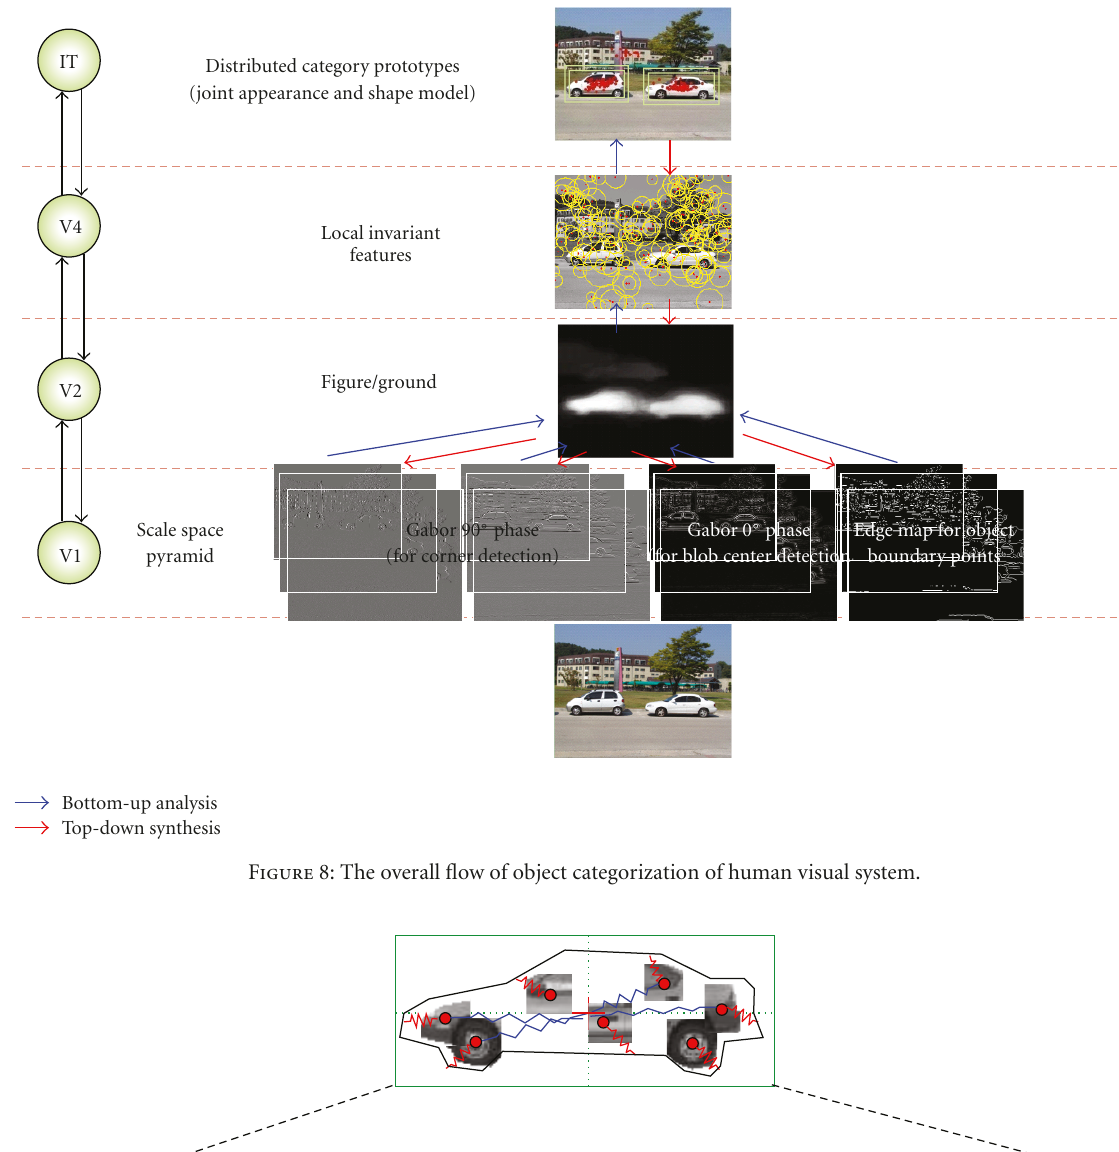
Figure 8: The overall flow of object categorization of human visual system.